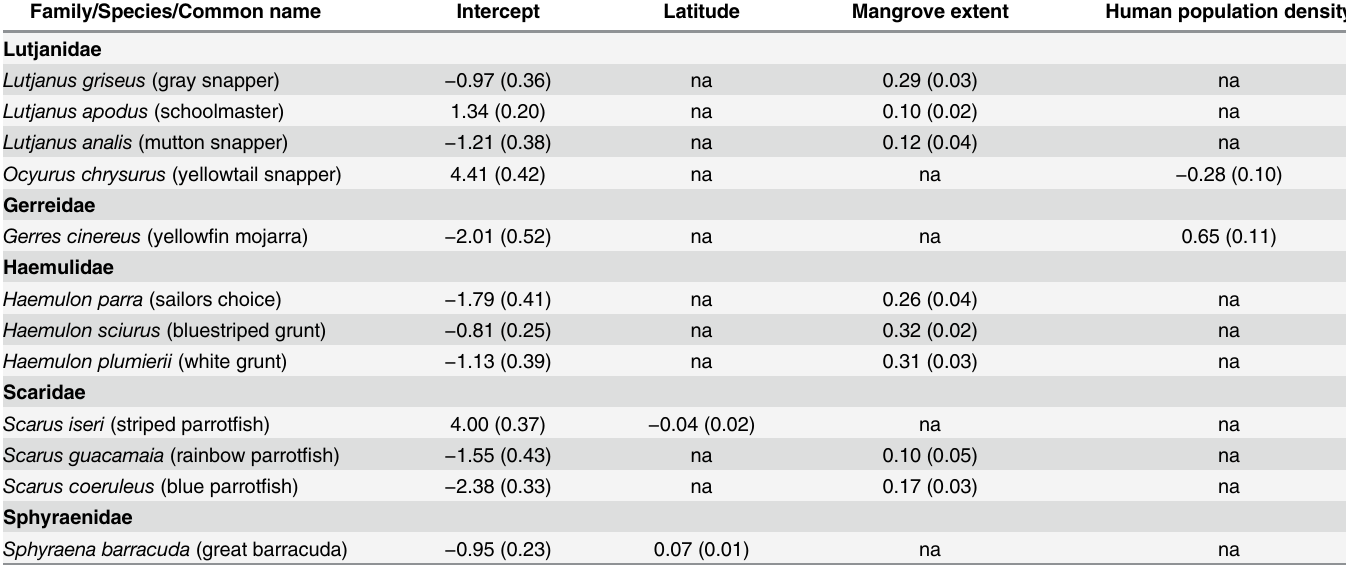
Table 1. Quantile (90 th ) regression results (model coefficients with standard errors in parentheses) describing the best approximating (based on Akaike information criteria, see text for details) linear relationships between mean index of reef fish abundance and latitude; the natural logarithm of mangrove extent (hectares); or the natural logarithm of human population density (people km – 2 ). na = variable not best approximating